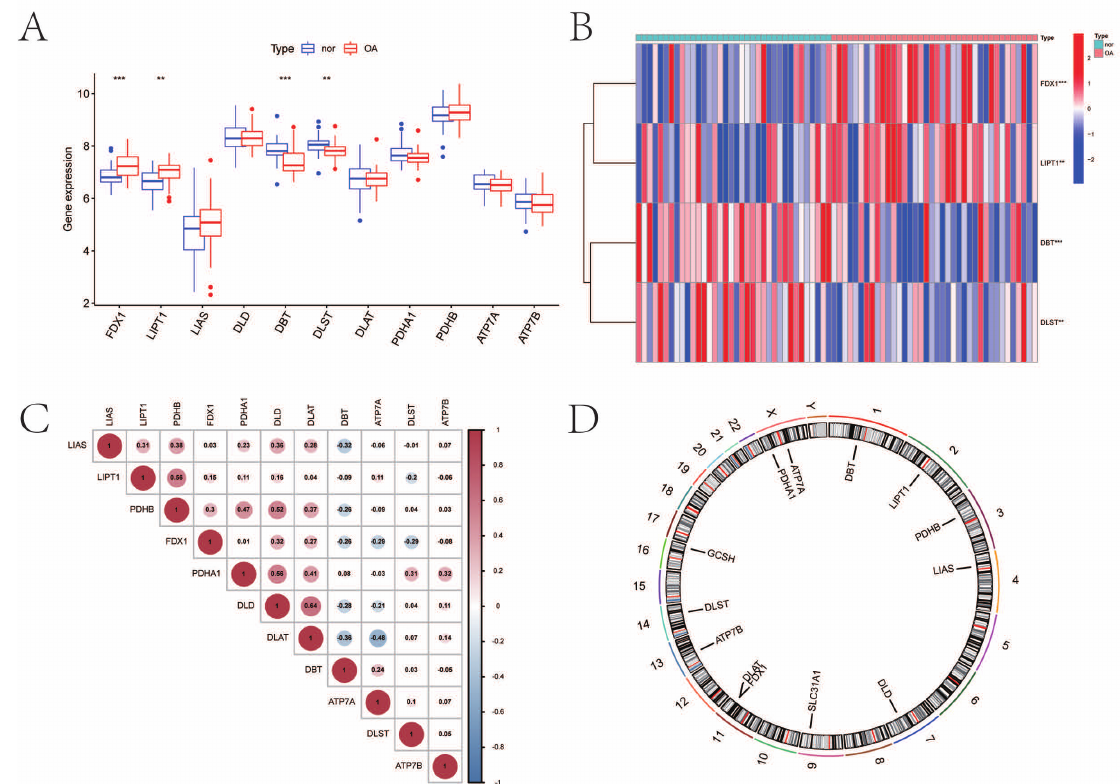
Figure 1. Expression characteristics and gene localization of CRGs. ( A ) Boxplot showing differences in the expression of CRGs in OA and normal tissues, with significant differences in the expression of 4 genes. ( B ) Heat map showing the expression characteristics of CRGs in OA tissues and normal tissues. Red showing high expression levels while blue showing low expression levels. ( C ) Spearman correlation analysis of CRGs; positive correlation is represented by red, while negative correlation is represented by blue. ( D ) The position of CRGs on the chromosome (for all figures: ** represents p < 0.01, and *** represents p < 0.001). CRGs, cuproptosis-related genes; OA,